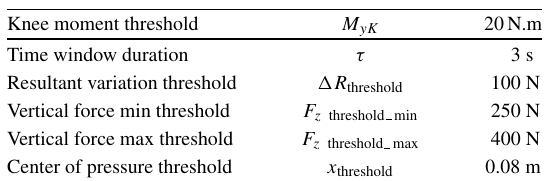
Table 1 Test threshold values used for patient